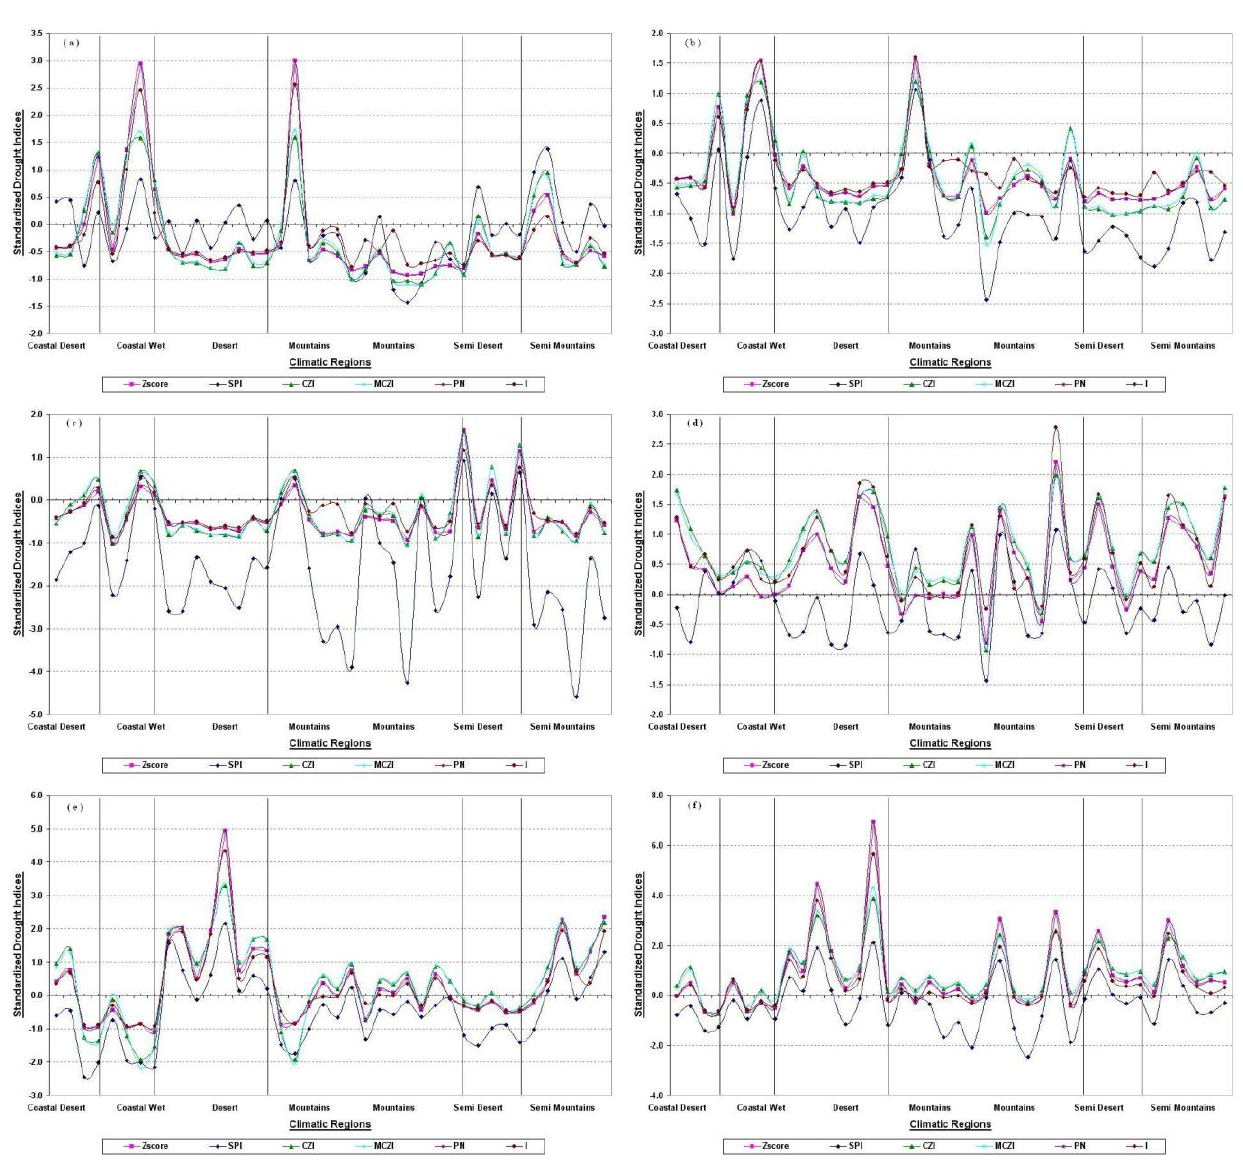
*X-axis represents study sites located in all six climatological